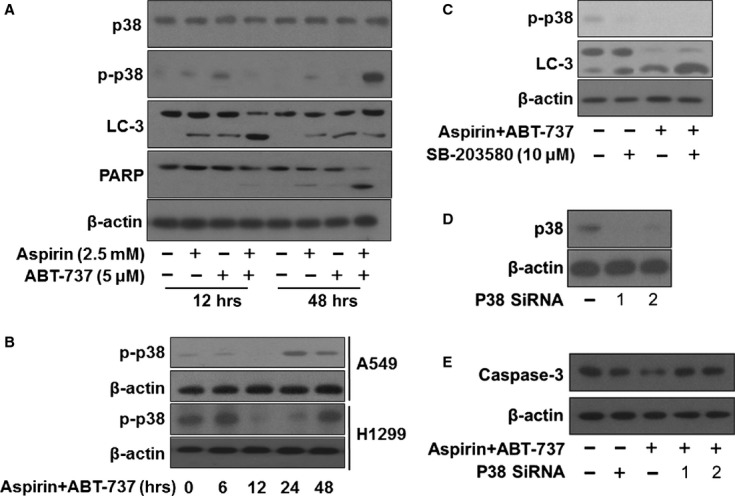
P38 MAPK acted as a switch for the transition from autophagy to apoptosis during combination treatment with aspirin and ABT-737. (A) A549 cells were exposed to aspirin (2.5 mM), ABT-737 (5 μM) or the combination for 12 and 48 hrs, after which protein extracts were immunoblotted using p38, p-p38, LC-3, PARP and β-actin. (B) A549 cells were exposed to aspirin (2.5 mM), ABT-737 (5 μM) or the combination for 6, 12, 24 and 48 hrs, H1299 cells were exposed to aspirin (5 mM), ABT-737 (20 μM) or the combination for 6, 12, 24 and 48 hrs, after which protein extracts were immunoblotted using p-p38 and β-actin. (C) A549 cells were pre-treated with p38 MAPK inhibitor SB-203580 (10 μM) for 1 hr and then treated with 2.5 mM aspirin and/or 5 μM ABT-737 for 12 hrs, after which protein extracts were immunoblotted using p-p38, LC-3 and β-actin. (D) A549 cells were transfected with control SiRNA, p38 siRNA-1 and p38 siRNA-2 according to the manufacturer's recommendations. Forty-eight hours after transfection, cell lysates were prepared for Western blot analysis. (E) The expression of caspase-3 in A549 cells that had been transfected with p38 siRNA and treated with 2.5 mM aspirin, either alone or in combination with 5 μM ABT-737, for 48 hrs were examined.